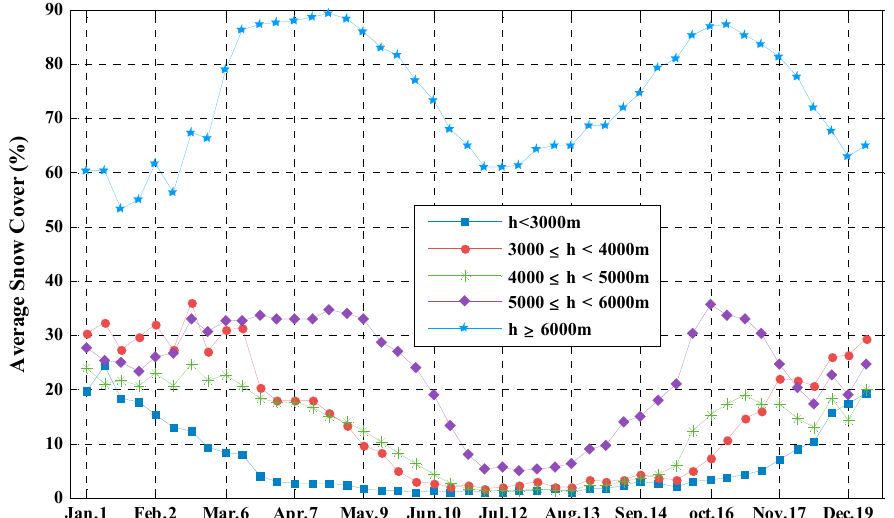
Figure 6. Seasonal variation of the 2001–2015 average snow cover in percentage of the snow-covered area with respect to the total area of each altitude range.